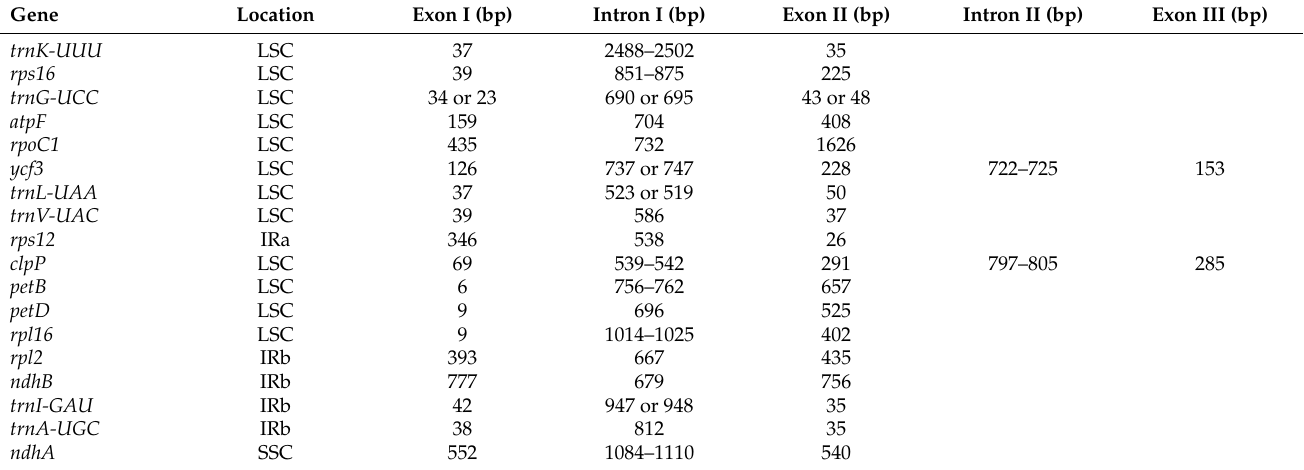
Table 4. Information of intron-containing genes in the chloroplast genome of the Camellia